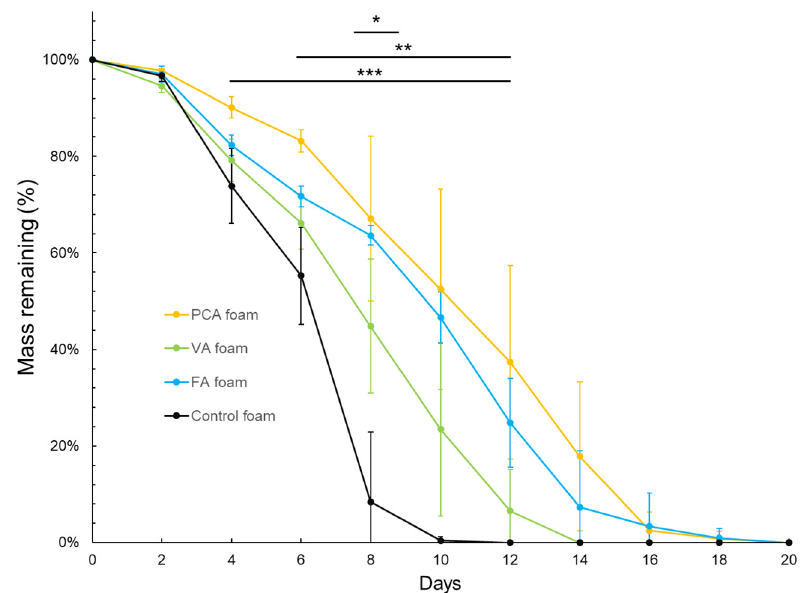
Figure 1. Gravimetric analysis of SMP foams in accelerated oxidative degradation media (20% H 2 O 2 ) over 20 days. n = 4, mean ± standard deviation displayed, * p < 0.05 between VA foam and control foam, ** p < 0.05 between FA foam and control foam, *** p < 0.05 between PCA foam and control foam.